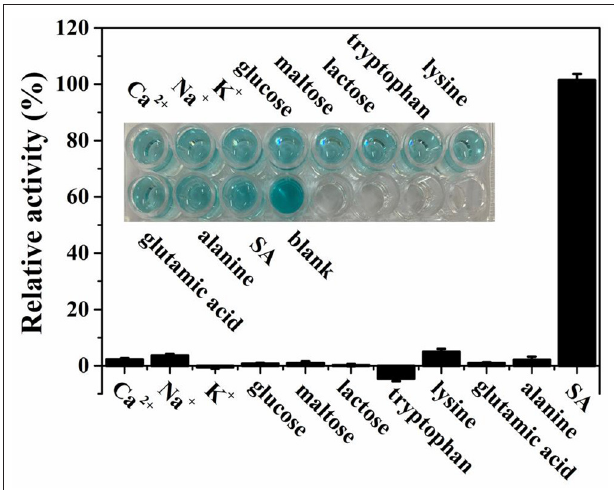
FIGURE 7 | Selectivity for SA detection with existence of several possible coexisting substances based on theMIL-53(Fe)-TMB-H 2 O 2 system. The inset shows the corresponding photograph of the interference